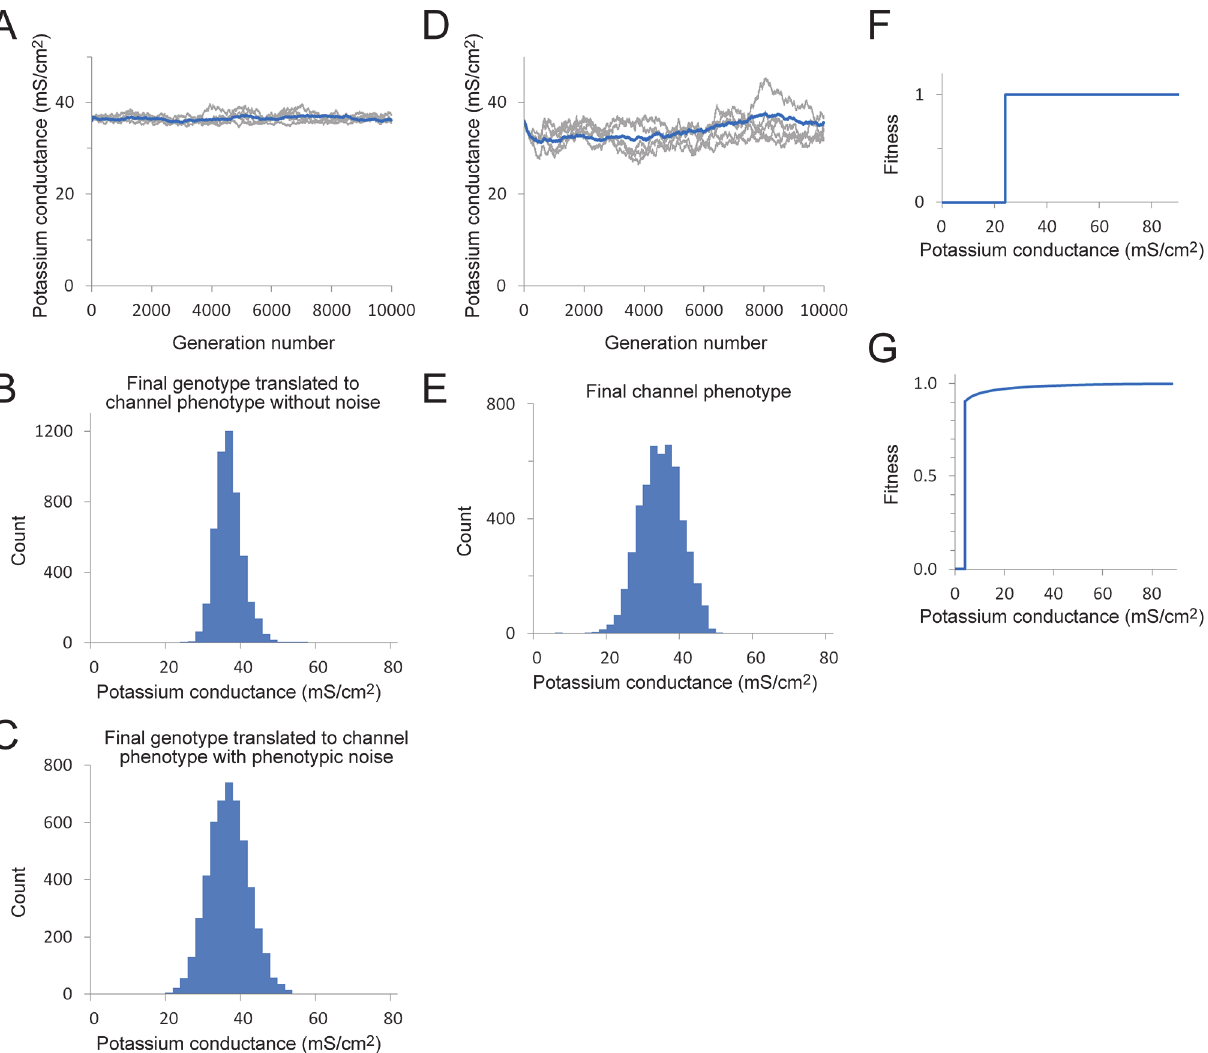
Fig 7. Effect of different selection criteria on potassium channel expression over successive generations. A. Evolution of potassium conductance phenotype with the fitness function shown in Panel F in combination with phenotypic noise. The average potassium conductance within the population remains stable over time (10000 generations, population = 5000). The blue line is the average value of ten simulations and five independent runs are shown in light grey on the same graph. The average final conductance value was 36.2 ± 0.5 mS/cm 2 (mean ± S.D., n = 10). B. Histogram showing representative final phenotype distribution translated directly from the final genotype without phenotypic noise to show the variation in the underlying potassium channel genotype. C. Histogram showing representative final phenotype distribution, including the effect of phenotypic noise. It is this distribution of potassium channel protein expression values, which varies slightly with each successive generation, that is subject to selection. Phenotypic noise was modeled as a binomial distribution ( N = 16) with an expected standard deviation of 4.0 mS/cm 2 . The N value for the noise distribution was selected by running successive simulations to obtain a best fit to the experimentally observed conductance value. Note that the distributions shown in (B) and (C) come from the same simulation run. D. Evolution of potassium conductance phenotype under selection for reduced action potential duration using the fitness function shown in Panel G. The average potassium conductance within the population remains stable over time (10000 generations, population = 5000). The blue line is the average value of ten simulation runs and five independent runs are shown in light grey on the same graph. The average final conductance value was 35.6 ± 3 mS/cm 2 (mean ± S.D., n = 10). E. Histogram of a representative final phenotype distribution. In this simulation no phenotypic noise was used so that the final channel phenotype maps directly from the final cis-regulatory genotype. F. The fitness function used in (A, B and C). This was based on the minimum potassium conductance required to produce Type 3 firing properties, i.e. suppress repetitive firing in response to a sustained depolarizing current injection (see Fig 3A and 3B). G. Fitness function used in (D and E). Action potential duration as a function of potassium conductance (see Fig 3D) was inverted, scaled and then combined with a fitness cliff at 3 mS/cm 2 , the value at which action potential conduction